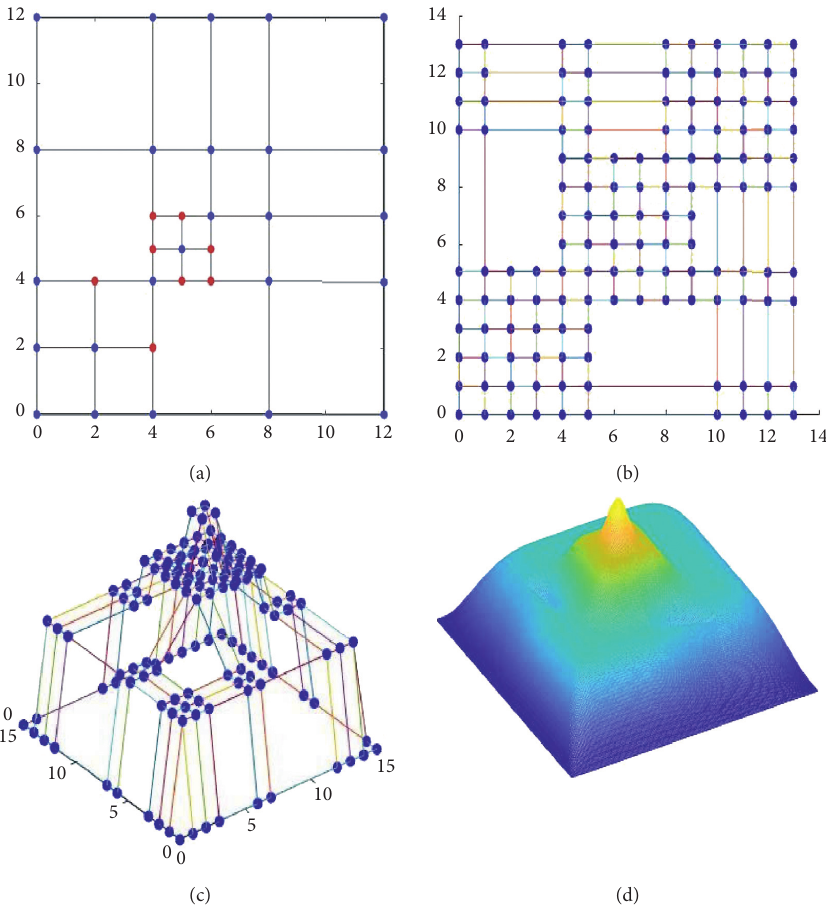
Figure 5: The index space and the control mesh. (a) A Design-suitable T-mesh. (b) The index mesh. (c) The control net. (d) The surface generated by the control net shown in